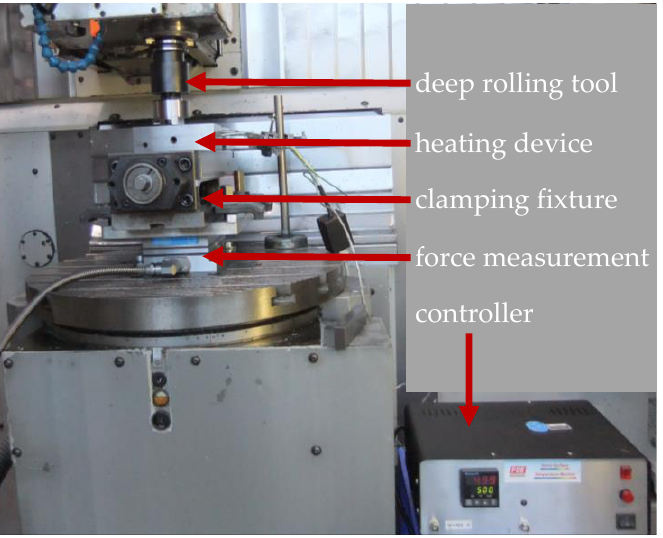
Figure 2. Experimental setup for deep rolling of prismatic workpieces at elevated temperatures.